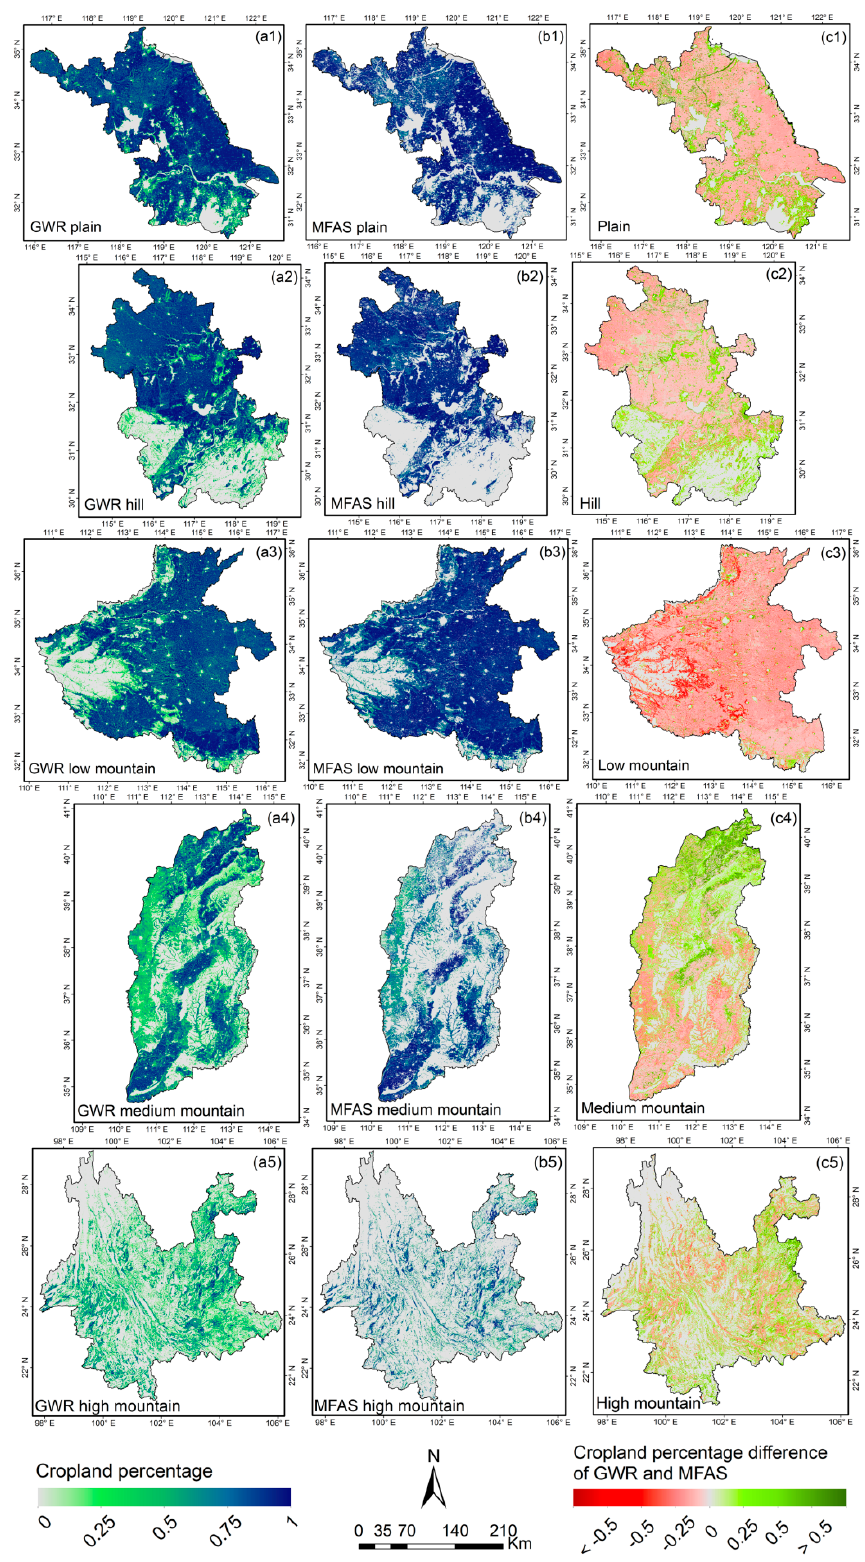
Figure 7. Synergy cropland maps of GWR ( left panel ) and MFAS ( middle panel ) and their difference images ( right panel ). Panels from top to bottom represent synergy results with various landscapes as shown in Table 4.